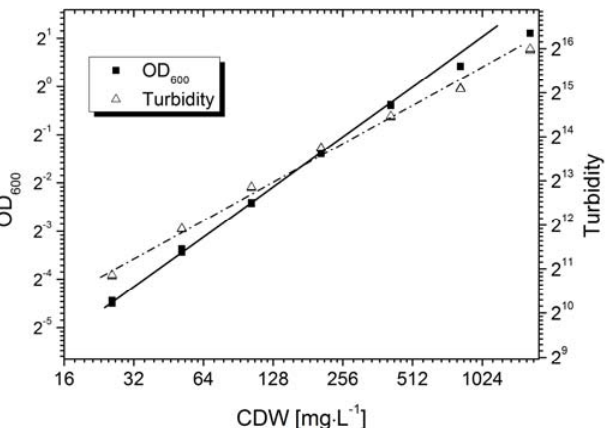
Figure 3. Calibration of optical density (OD 600 ) and the AFG sensor in B. coagulans LA fermentation broth. CDW = cell dry weight. The sensor values in each sample were recorded every 10 s for a total duration of 1 min. All data are shown in the figure.